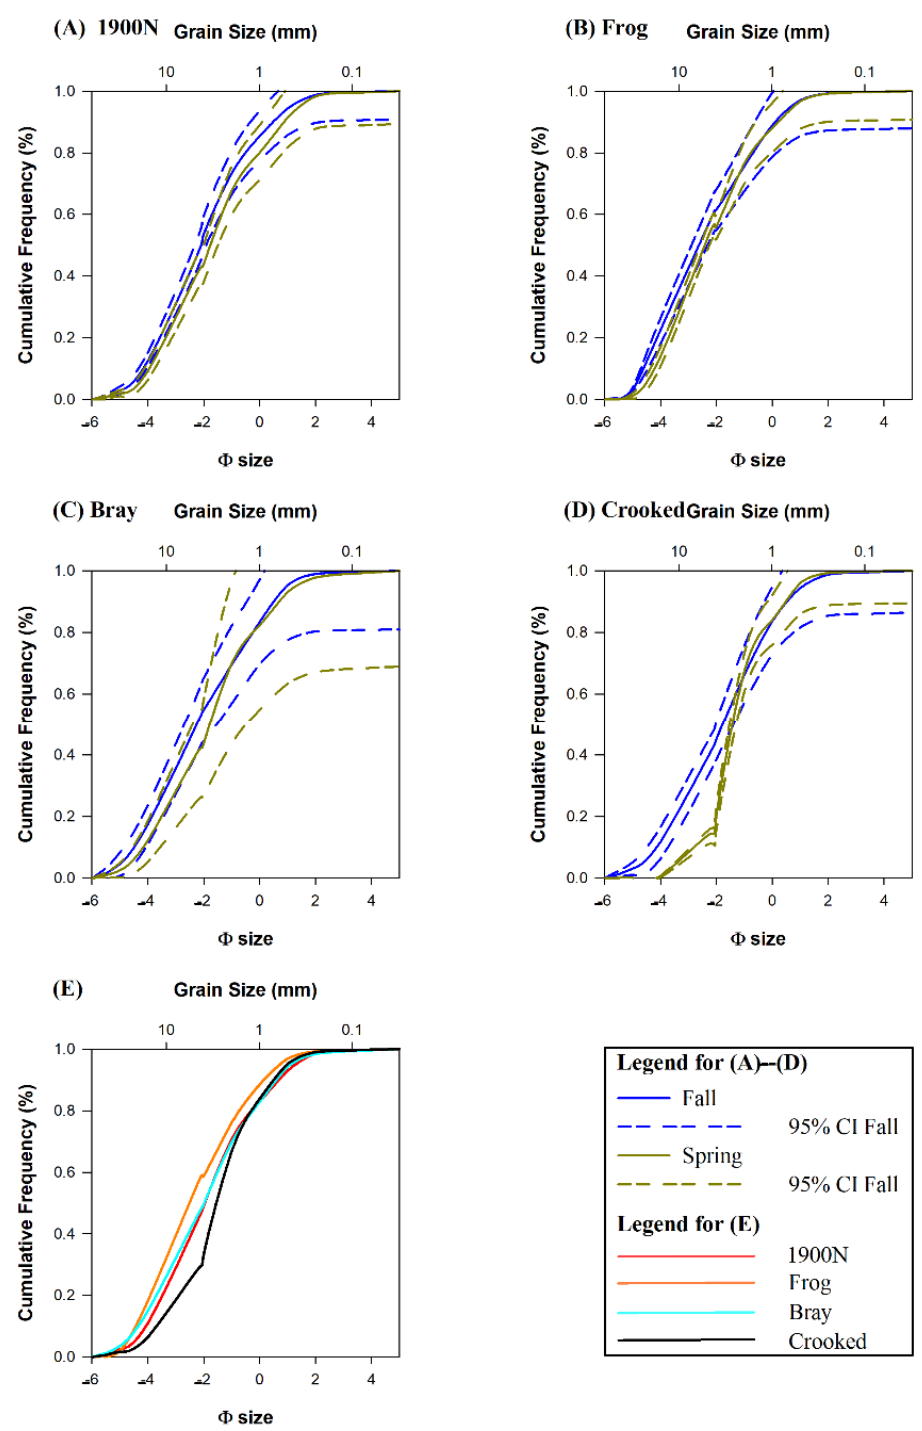
Figure 6. Cumulative frequency curve (solid) and 95% confidence interval (dashed) of each stream during the fall (blue) and spring (green). ( A ) 1900N—5 years; ( B ) Frog Creek—7 years; ( C ) Bray Creek—30 years; ( D ) Crooked Creek—unmodified; ( E ) cumulative frequency curve for the combined sediments samples for the four streams.